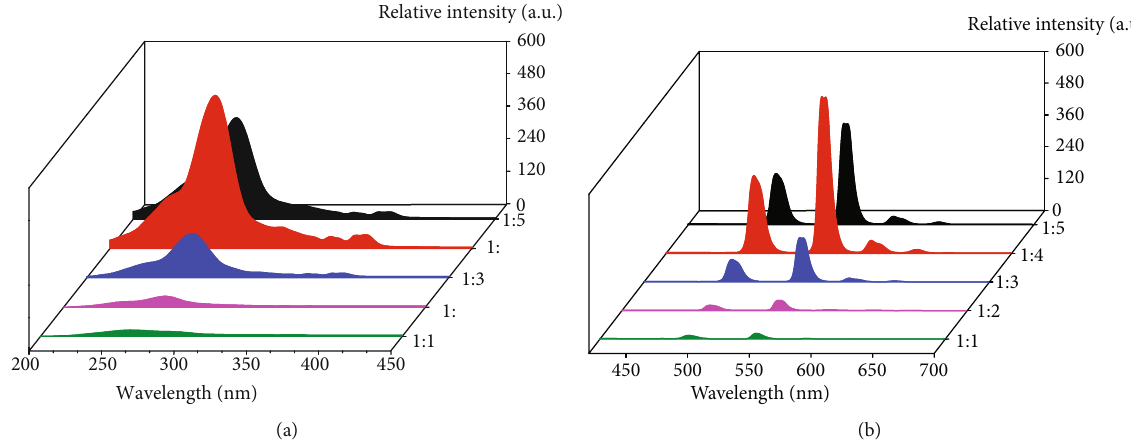
Figure 6: Excitation spectra (a) and emission spectra (b) of the 10-UA-Tb(III) complex.